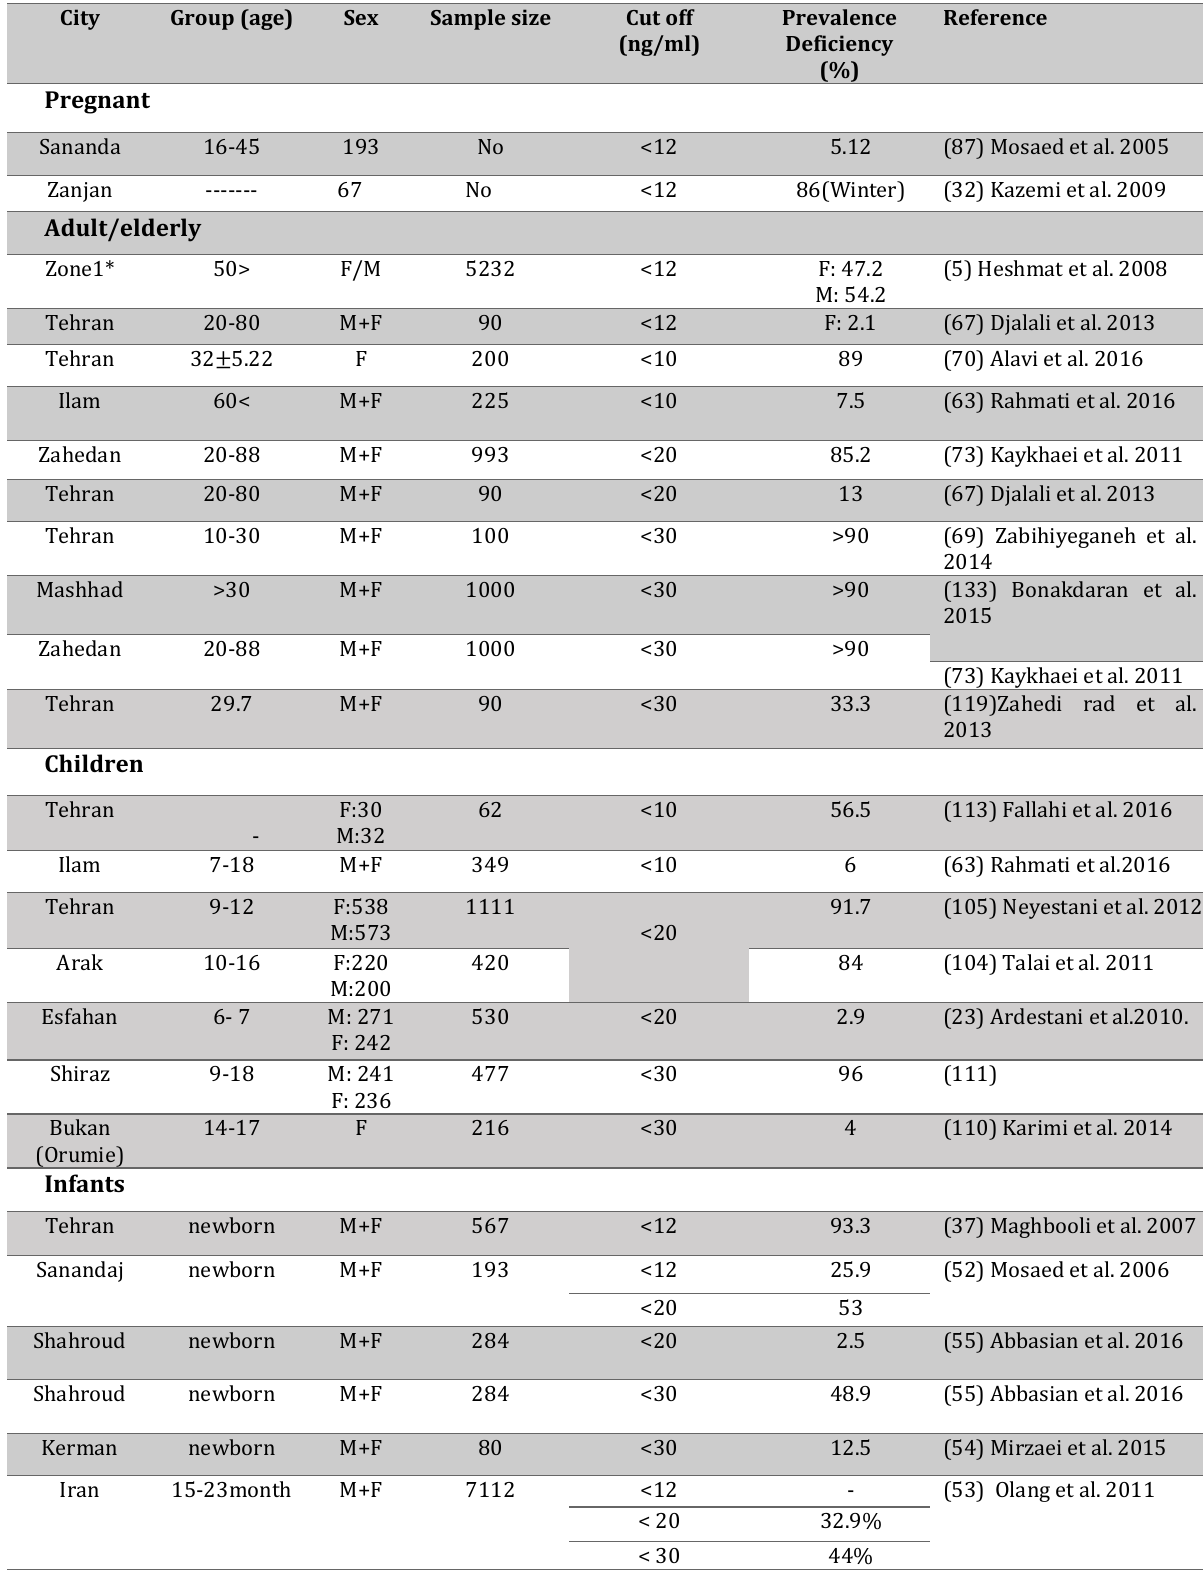
Table 5. The provinces with the highest and lowest rate of prevalence of Vitamin D deficiency and Vitamin D insufficiency in Iran. City Group (age) Sex Sample size Cut off